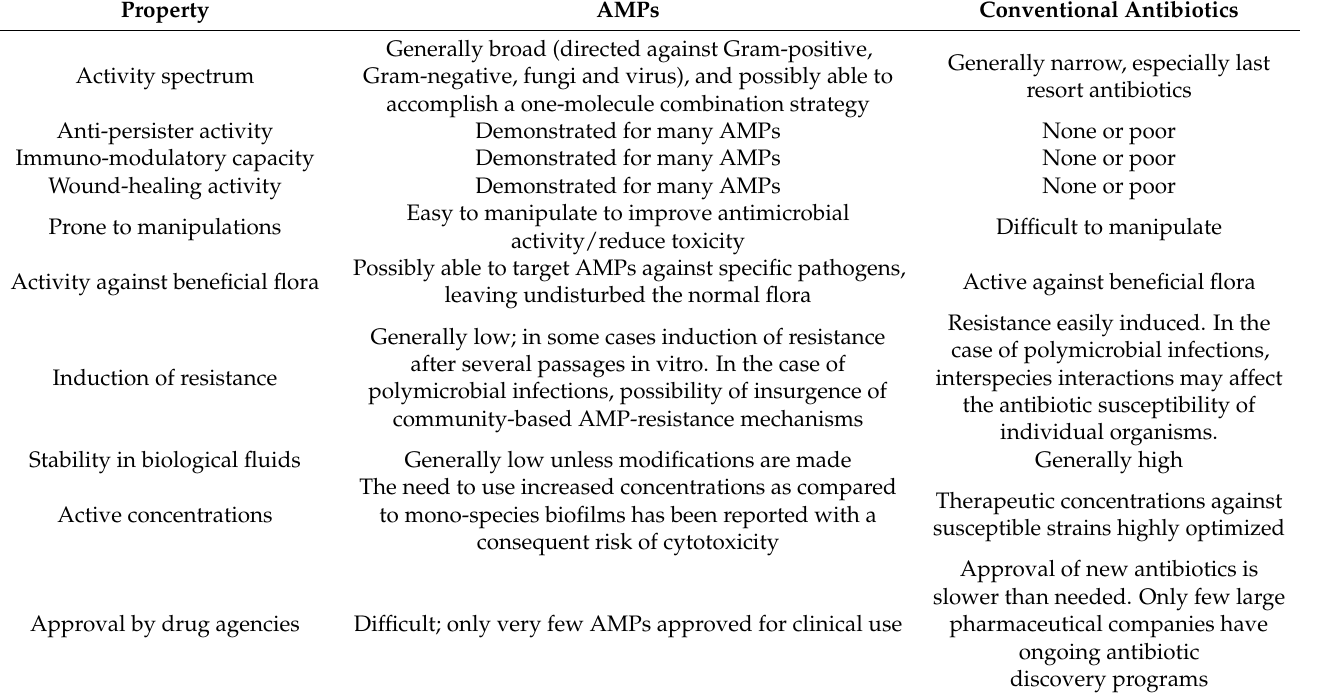
Table 2. Possible advantages and limits of AMPs against polymicrobial biofilm-associated infections as compared to conventional